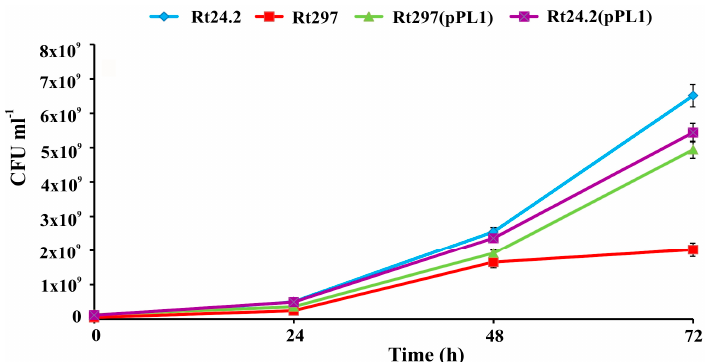
Figure 5. Growth kinetics of the wild-type strain R. leguminosarum Rt24.2 and its derivatives in 79CA medium. The given values are averages ± SD of two independent experiments with three biological replicates for each strain analyzed.